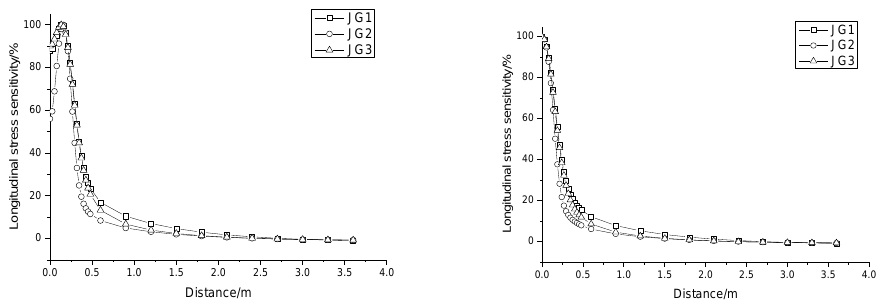
Figure 5. Transverse stress sensitivity of the lower surface layer bottom of three structures (unit: %).